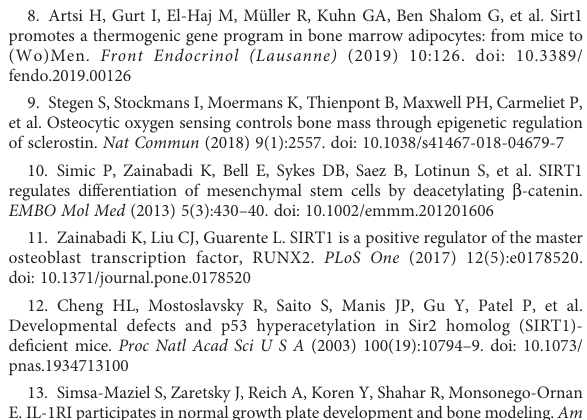
SUPPLEMENTARY FIGURE 1 Body weight determined at age 2, 7, 12 months in: (A). female Sirt1 +/ D and WT mice (B). male Sirt1 +/ D and WT mice. Results are Mean ± SEM analyzed by unpaired Student ’ s t -test; ** P <0.01 versus WT mice (n=7-11 mice/group) SUPPLEMENTARY FIGURE 2 Femoral length determined at age 2, 7, 12 months in: (A) . female Sirt1 +/ D and WT mice (B). male Sirt1 +/ D and WT mice. Results are Mean ± SEM analyzed by unpaired Student ’ s t -test; ** P <0.01 and **** P <0.0001 versus WT female